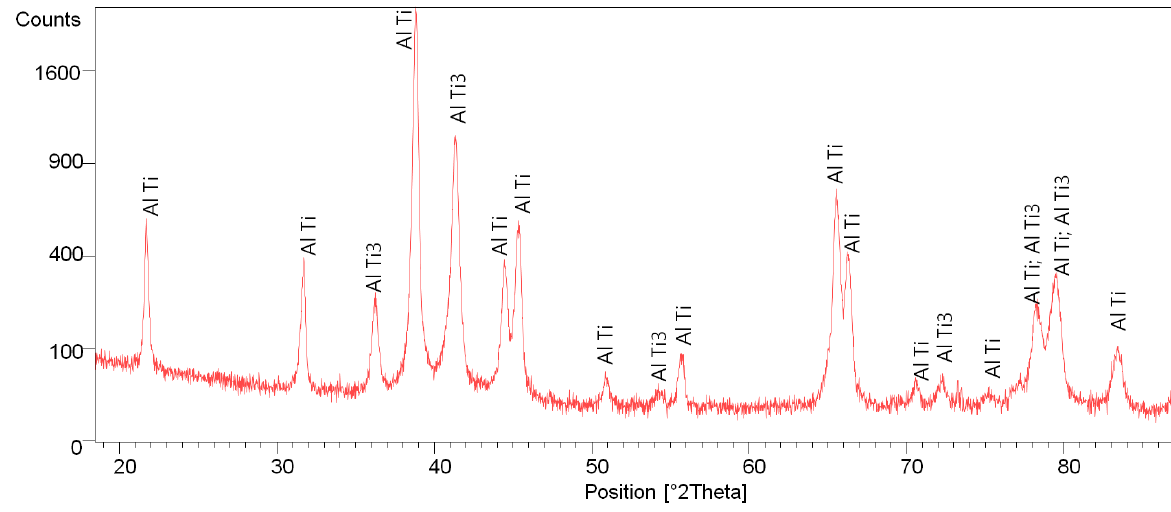
Figure 3: XRD pattern showing the alloy